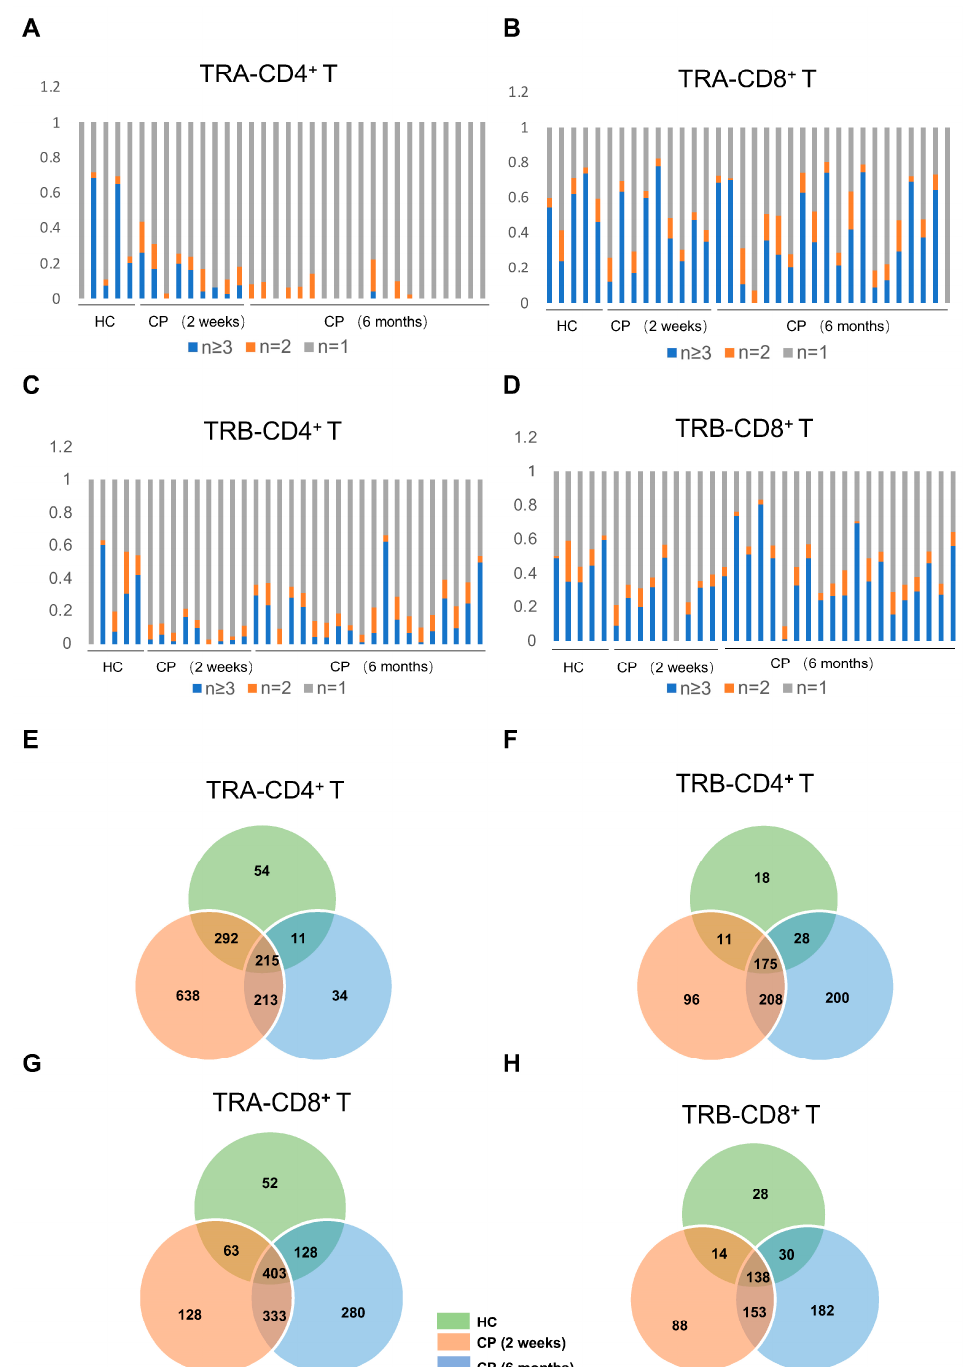
Figure 2. The types of TCR α (TRA) and TCR β (TRB) clones from CD4 + T and CD8 + T cells of COVID-19 patients with 2-week and 6-month convalescence phase and healthy controls are shown ( A – D ). The TCR distribution TRA ( A , B ) and TRB ( C , D ) in CD4 + T and CD8 + T cells of convalescence COVID-19 patients (CP) and healthy controls (HC) are shown. Unique (n = 1), duplicated (n = 2), and clonal (n ≥ 3) TCRs are marked with different colors ( E – H ). The Venn diagram shows that the common and specific TRA ( E , G ) and TRB ( F , H ) numbers in CD4 + T and CD8 + T cells of convalescence COVID-19 patients (CP) and healthy controls